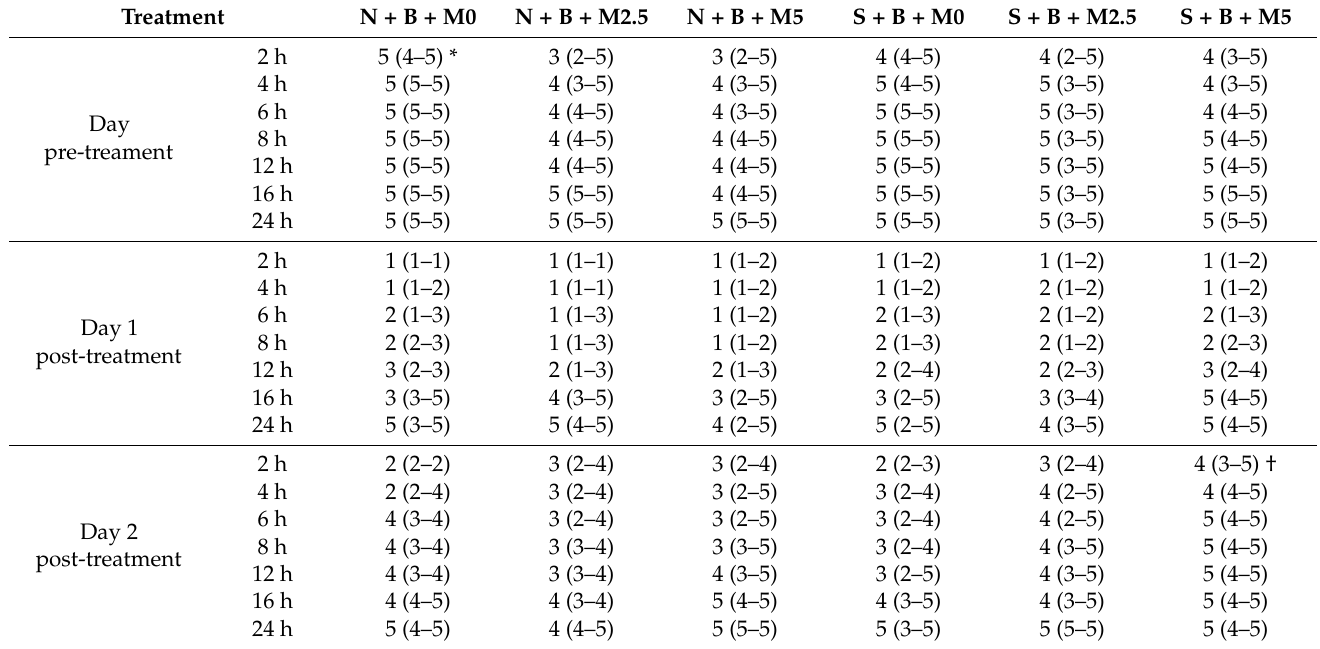
Table 2. Comparison of nest consolidation scores before and after treatment. Data are presented as median (25 – 75% percentile). *, value significantly differs ( p < 0.03) between the N + B + M0 and N +